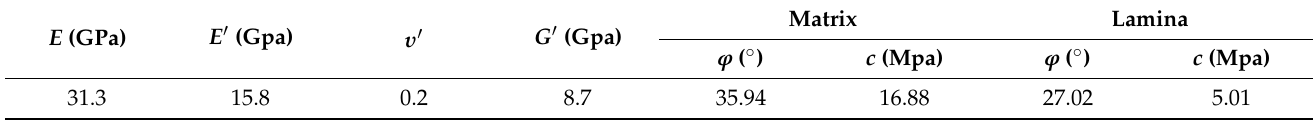
Table 6. Transversely isotropic mechanical parameter values of continental